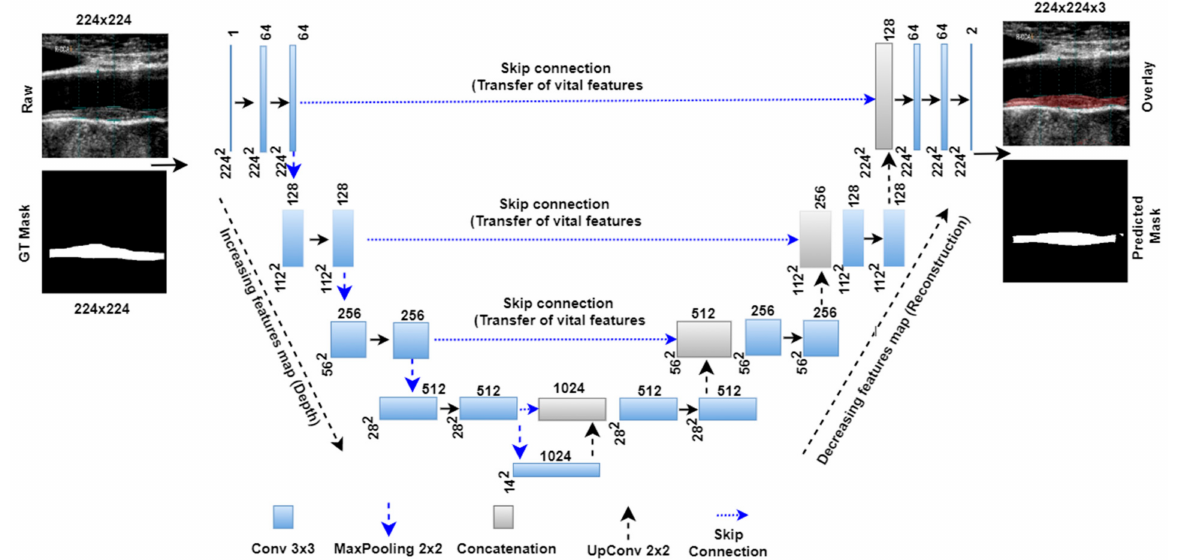
Figure 2. Basic Unet model with four encoder and decoder stages.